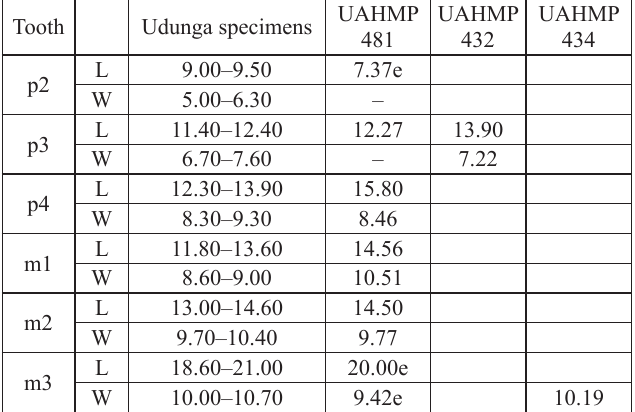
Table 1. Measurements (in mm) of the teeth of Capreolus constantini from the Pliocene of Santa María Amajac, Hidalgo (central Mexico) and Udunga (Russia). Data for Udunga specimens were taken from Vislo- bokova et al. (1995). Abbreviations: e, estimated; L, length; W, width. Udunga